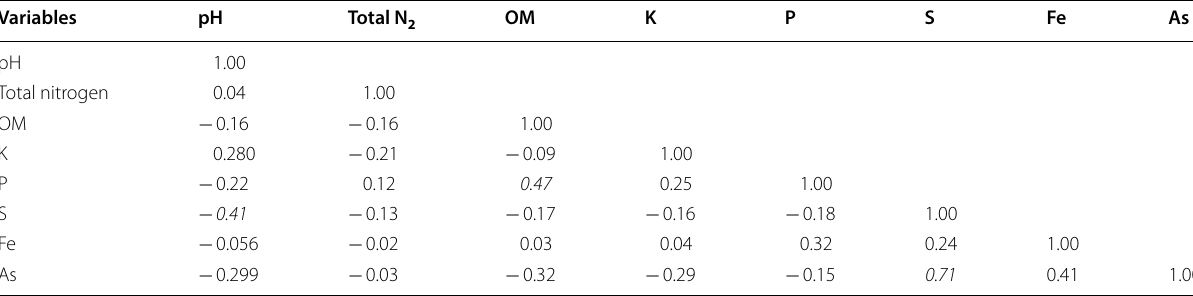
** Italic values indicate the significant correlation between the various chemical parameters